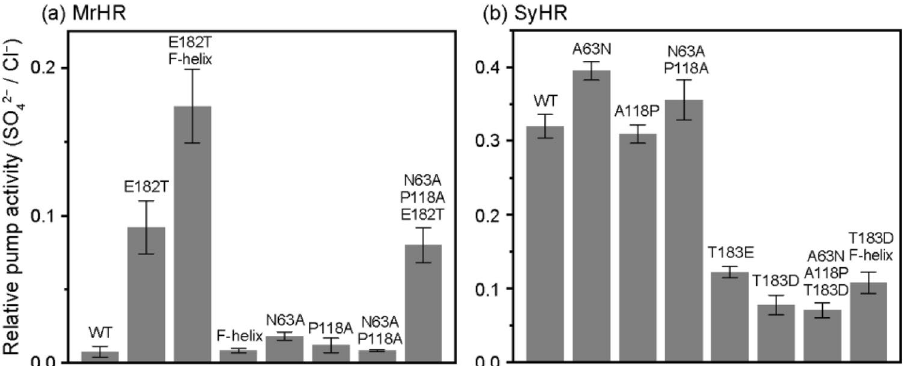
Figure 3. Relative SO 42− pump activities with respect to the corresponding Cl − pump activities. These values were calculated from the initial slopes of pH changes in Fig. 2 (for details, see text) and plotted in ( a ) for MrHR and the mutants and in ( b ) for SyHR. Each bar indicates the mean ± standard deviation (n =